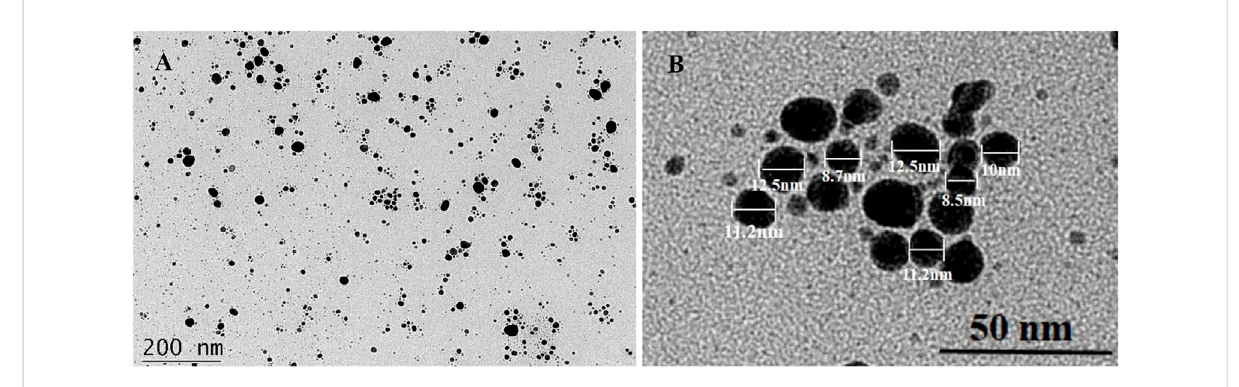
FIGURE 5 TEM images of dispersed Lceo-AgNPs.